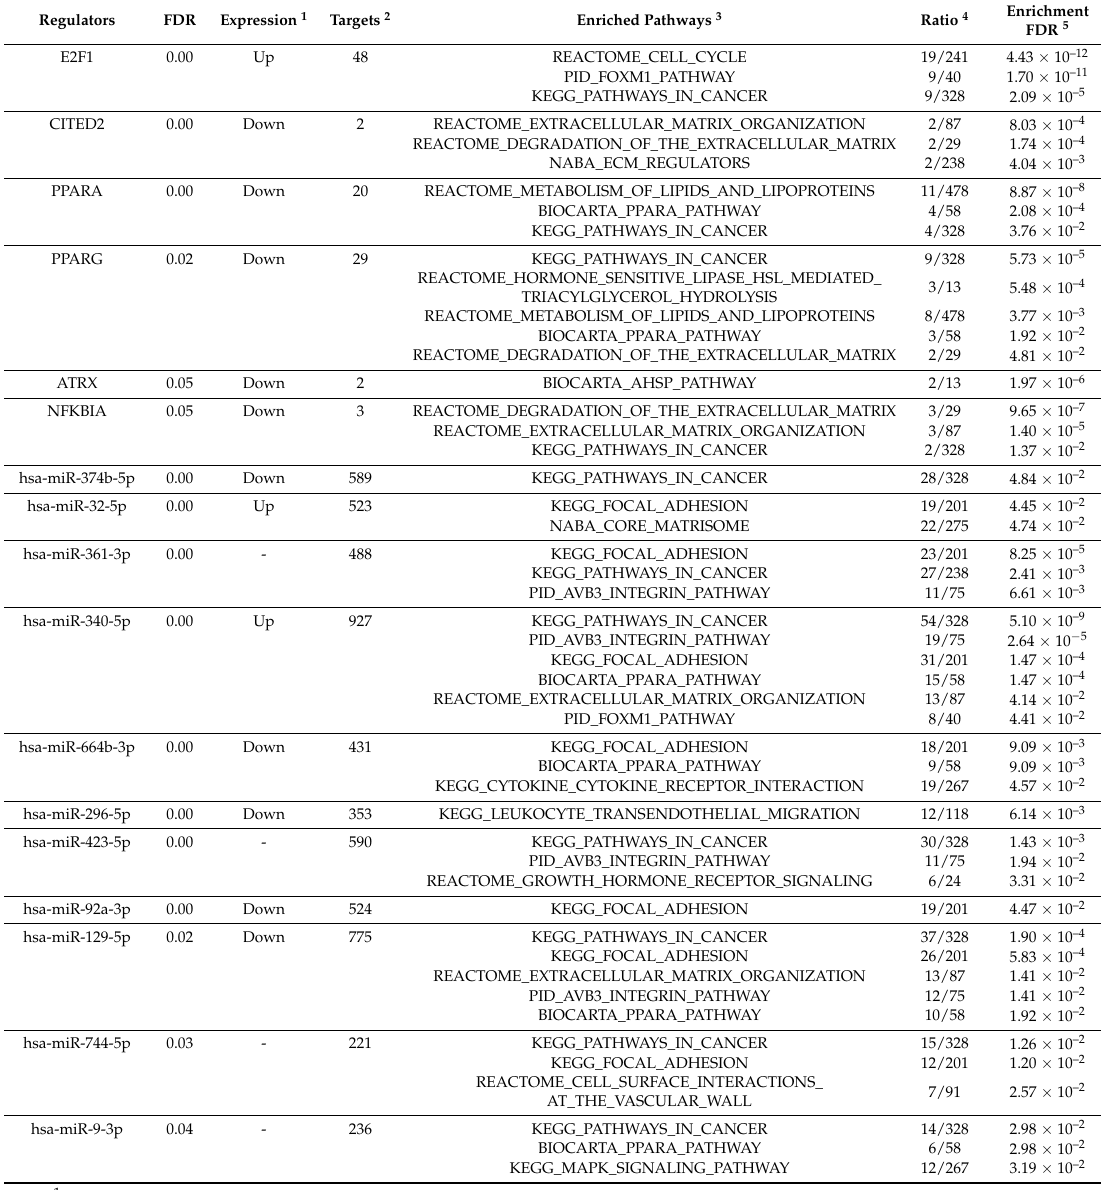
1 The miRNA/TF expression pattern in 112 TN patients when compared to the 113 adjacent normal breast tissue samples (TCGA data set was used); 2 The number of predicted targets provided by TRRUST v2.0 or starBase v3.0 overlapped with Yin and Yang genes; 3 The enriched canonical pathways from MSigDB in the target Yin and Yang genes of the corresponding regulator; 4 The number of the targets involved in a pathway and the total number of genes involved in the pathway; 5 The BH method adjusted hypergeometric test p -value for the corresponding enriched